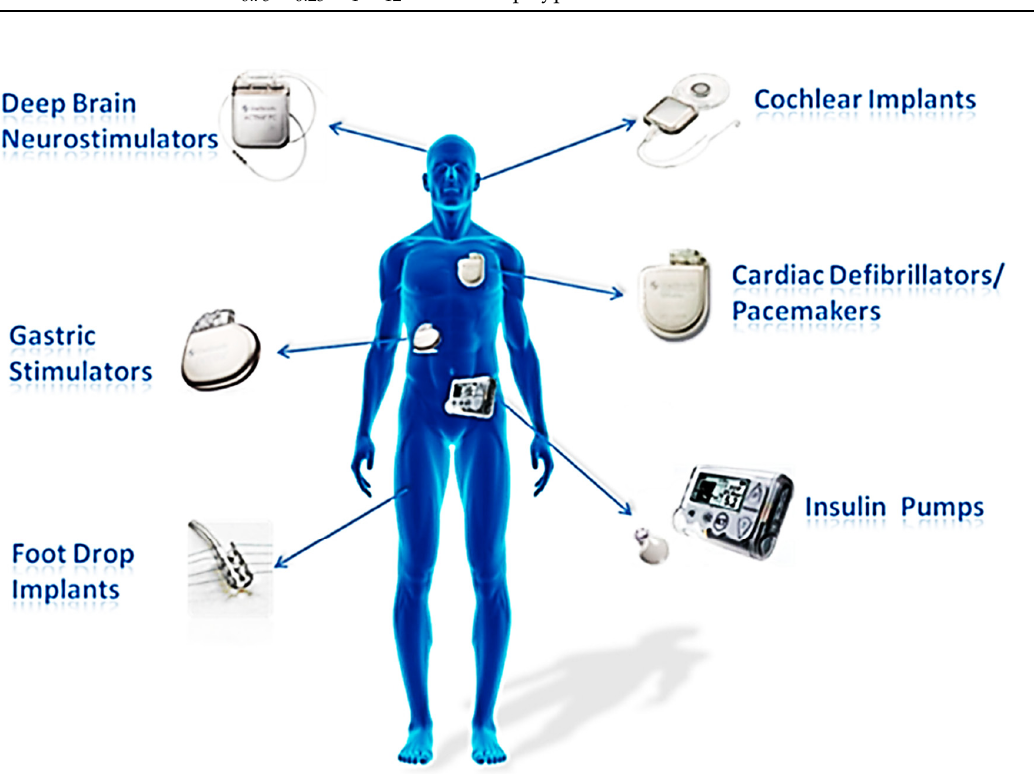
Figure 6. Common semiconductor implantable devices. (Reprinted with permission from ref. [168]. Copyright 2019 PM Kumar et al).